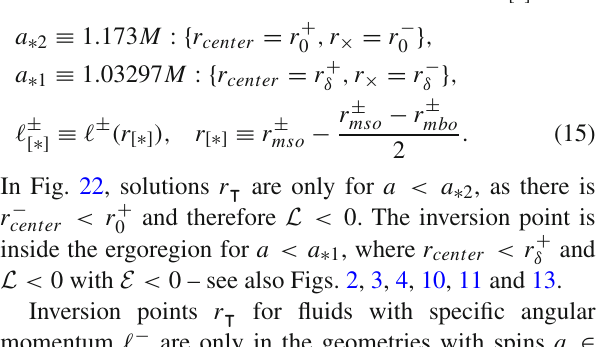
a > a mbo , proto-jets and tori cusps are out of the ergoregion – see Figs. 1 and